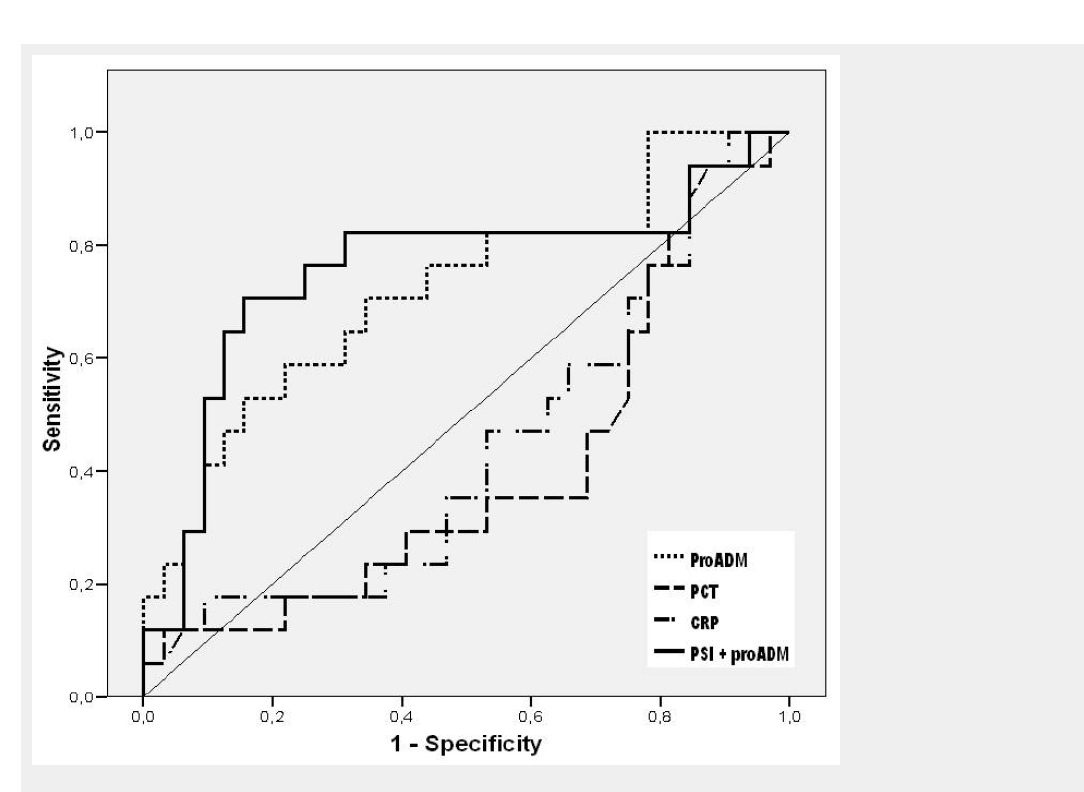
Figure 4 ROC curve analysis of PSI+ProADM on predicting hospital